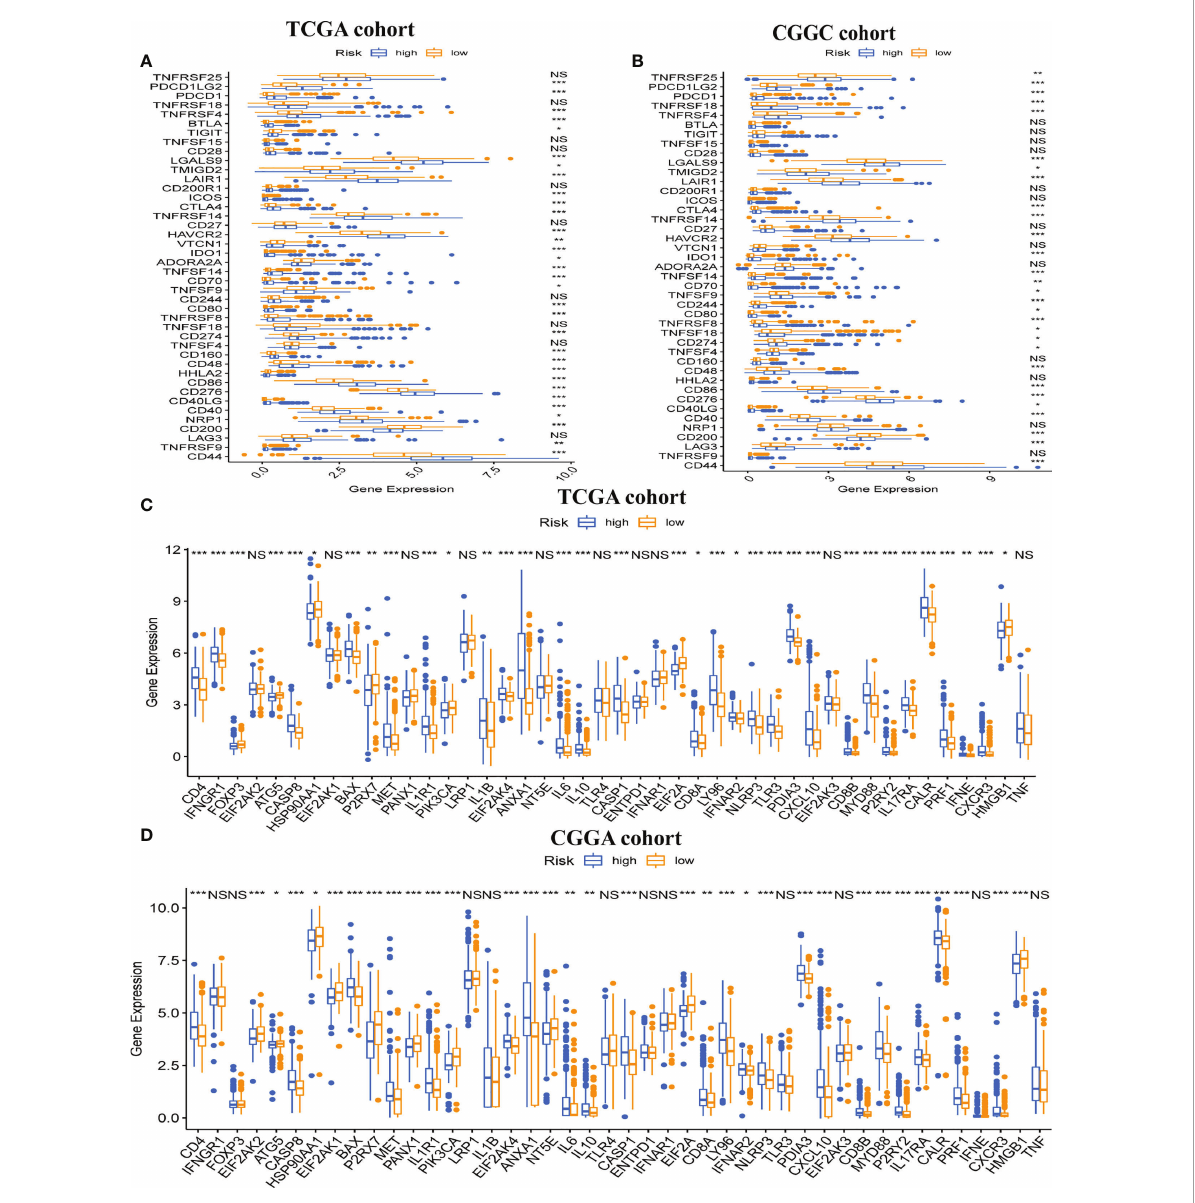
FIGURE 7 Association between risk subtypes and ICPs and ICD modulators. Differential expression of ICP genes among the risk subtypes in (A) TCGA and (B) CGGA cohorts. Differential expression of ICD modulator genes among the risk subtypes in (C) TCGA and (D) CGGA cohorts. NS, Non Signi fi cance, ***p < 0.001, **p < 0.01, *p <